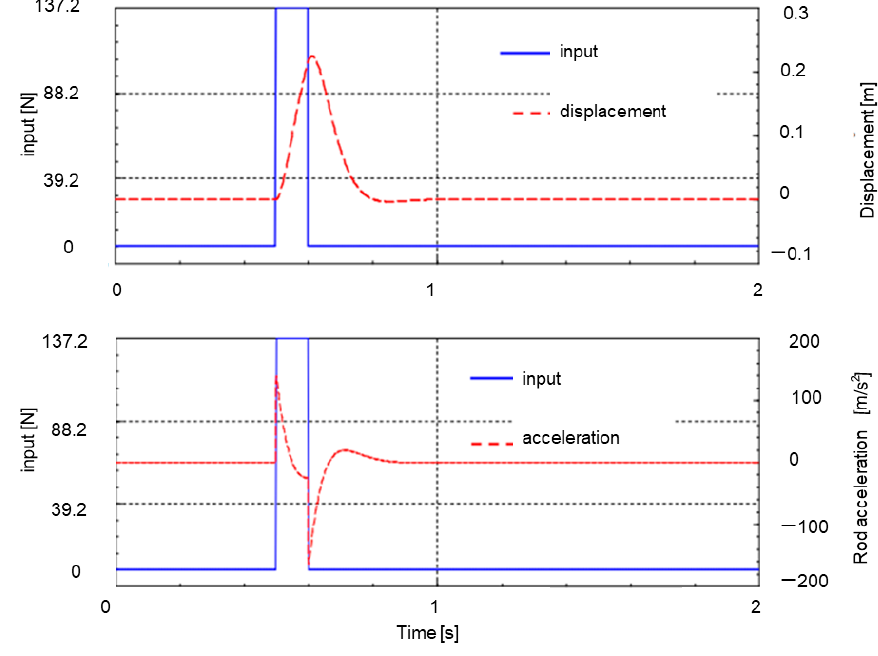
Figure 7. Time vs. rod displacement and acceleration by using air compressibility.